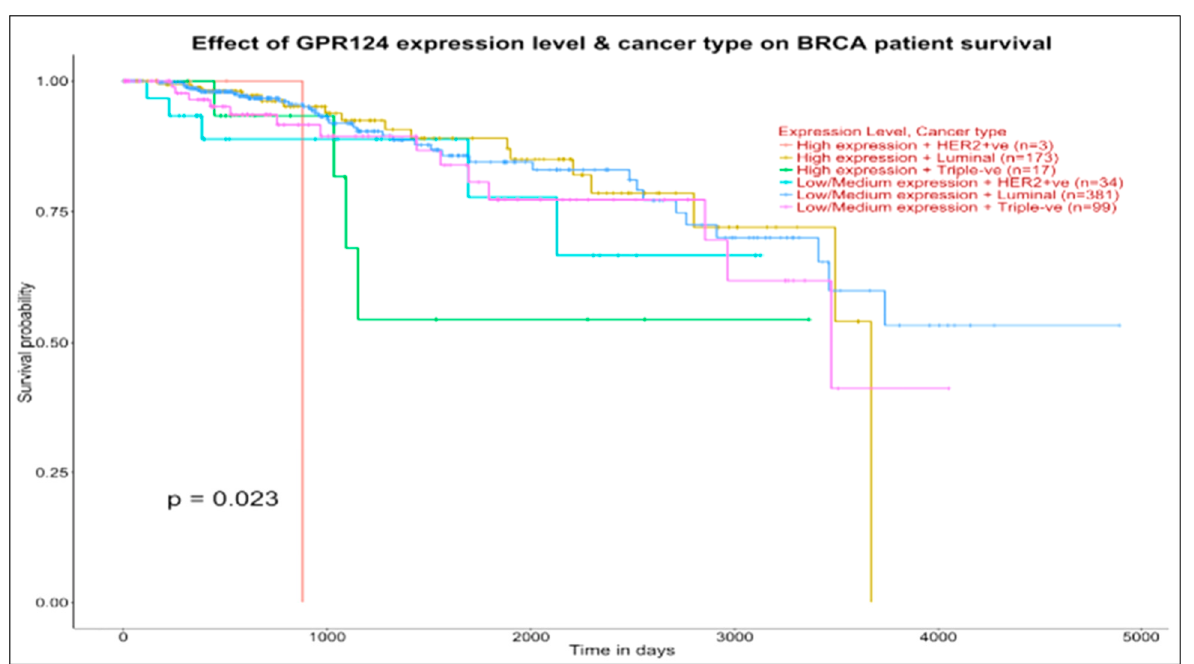
Figure 6. Luminal selections with prognostic impact on breast invasive carcinoma (BRCA) patients. Source: UALCAN. Significance of survival impact is measured by log rank test (the lower is the p -value, the better is the separation between groups).